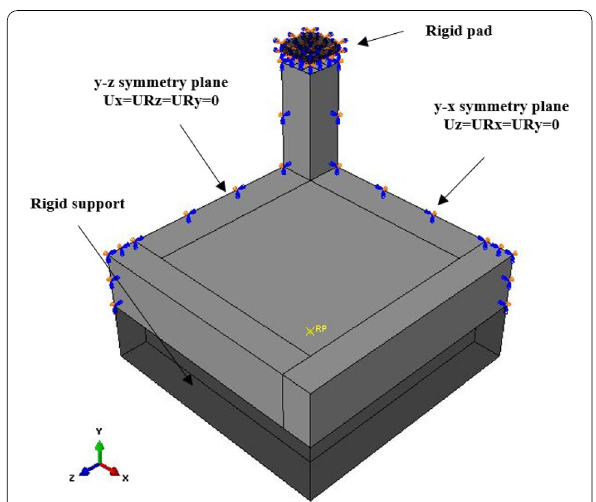
Fig. 15 Geometry and boundary conditions.